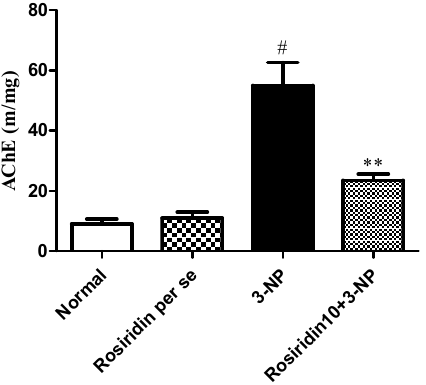
Figure 11. Effect of rosiridin on acetylcholinesterase (AchE) levels. Values are expressed as the mean ± SEM (n = 6). Values are statistically significant at p < 0.05 (one-way ANOVA followed by Dunnett’s test). Express the data ( # p < 0.05) saline vs. negative control group; (** p < 0.01) negative control group vs. treatment group.